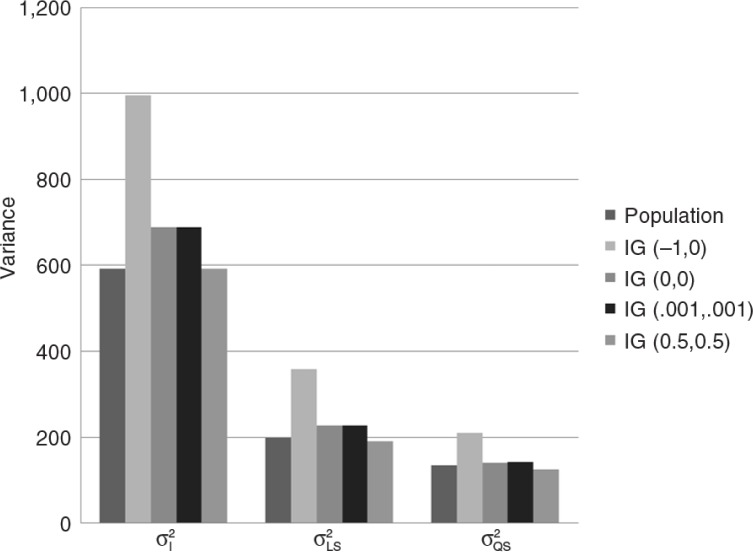
Simulation results for different priors for IG(α0, v0).